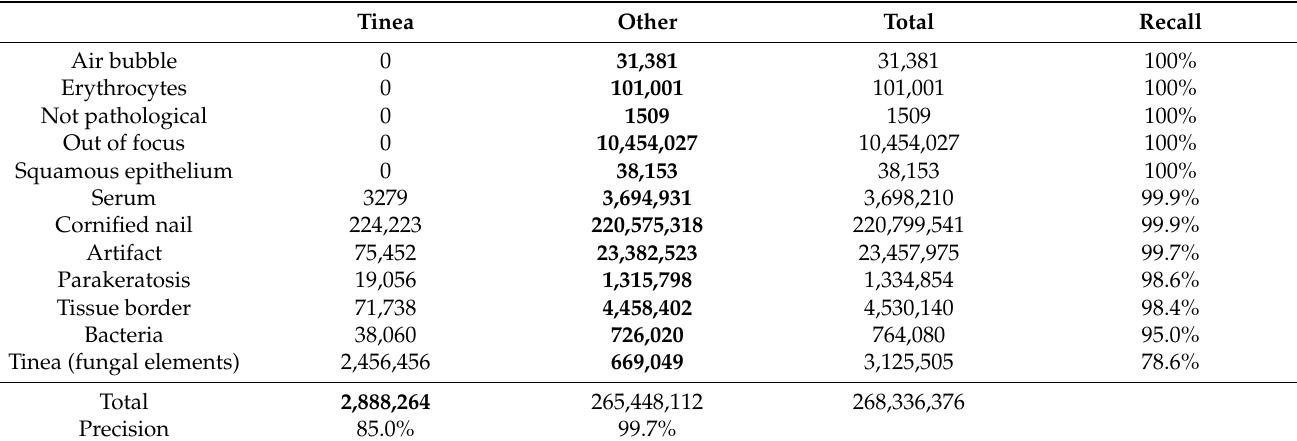
Table 2. Per pixel evaluation. Exact number of predicted pixels can be seen in the two columns. In bold, we highlight correct